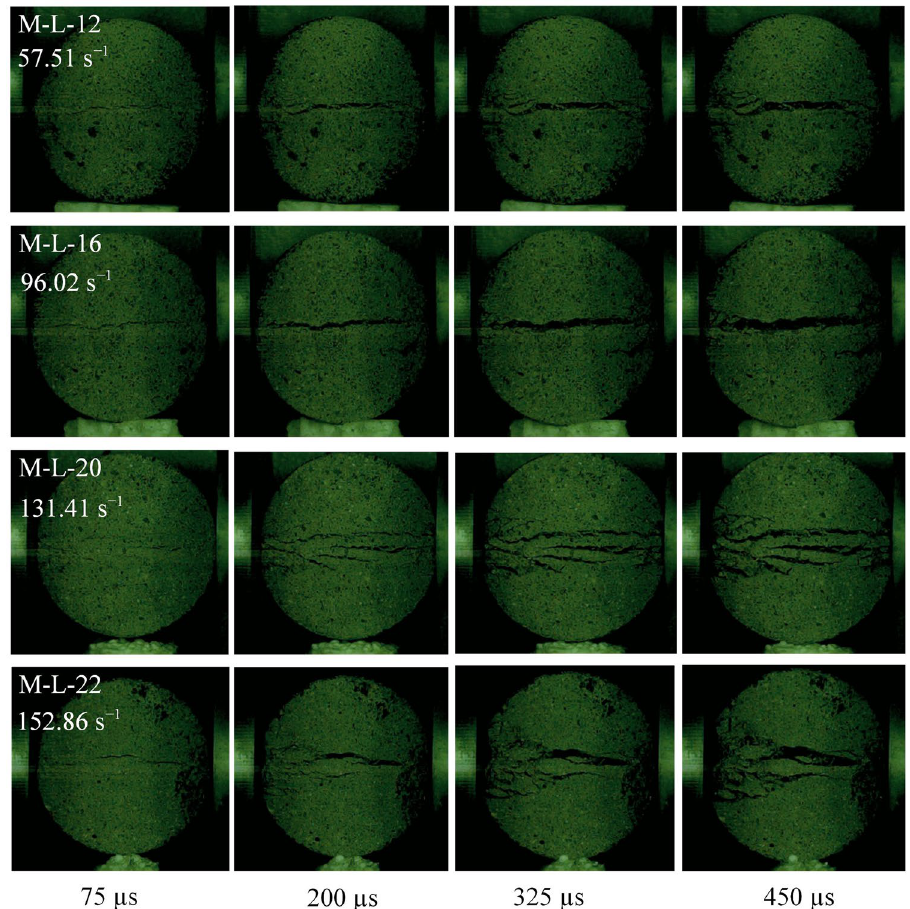
Figure 13. Failure process in mortar BD specimens with a thickness of 30 mm under different strain